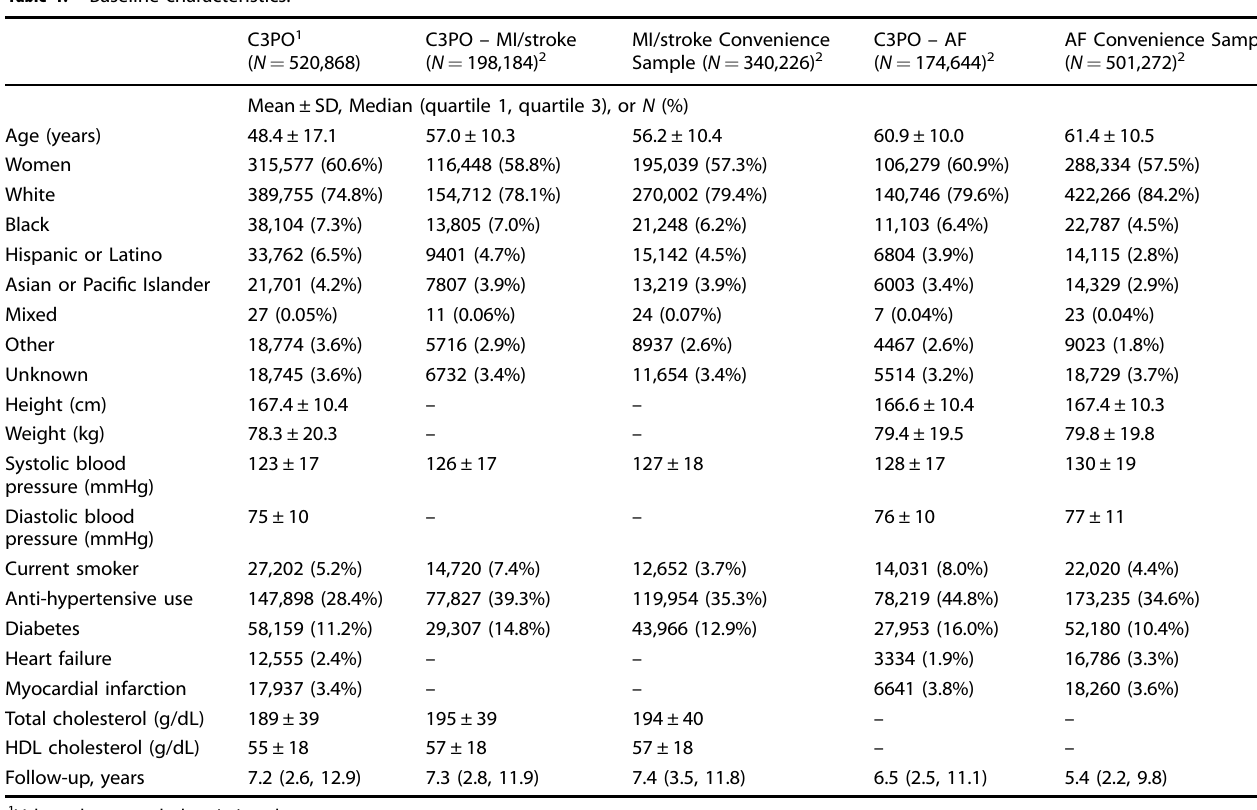
Table 1. Baseline